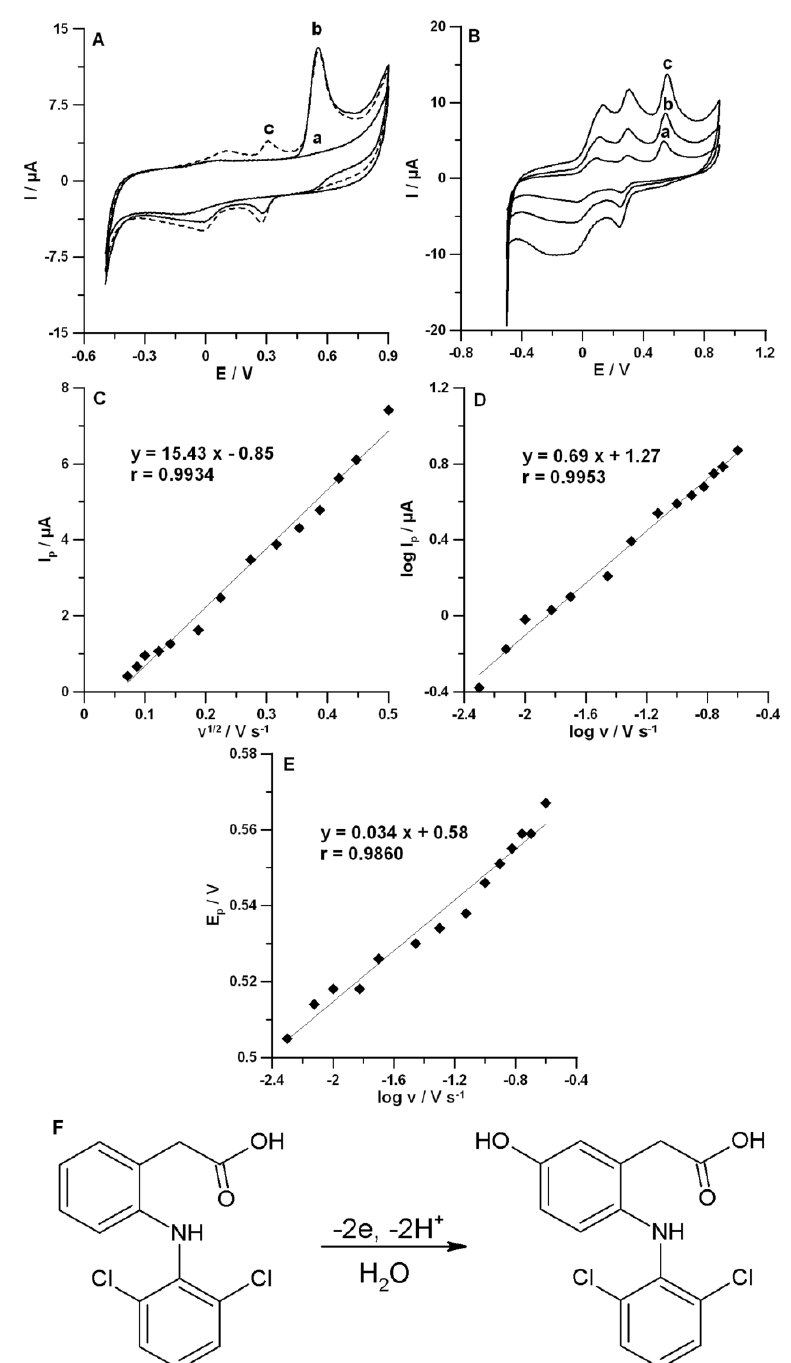
Figure 4. ( A ) CV curves recorded in the 0.1 mol L − 1 NaAc–HAc bu ff er solution with a pH value of 4.0 ± 0.1 at v equal to 175 mV s − 1 . Curves (a–c) represent CV curves in the solution without DF and with 1.0 µ mol L − 1 DF for the first cycle and the second cycle, respectively. ( B ) CV curves recorded in the 0.1 mol L − 1 NaAc–HAc bu ff er solution with a pH value of 4.0 ± 0.1 containing 1.0 µ mol L − 1 DF at di ff erent v values. Curves (a–c) represent CV curves at v equal to 50, 100, and 175 mV s − 1 , respectively. The dependences between Ip and v 1 / 2 ( C ), log Ip and log v ( D ), and E p and log v ( E ) for v from 5 to 250 mV s − 1 . ( F ) Oxidation mechanism of